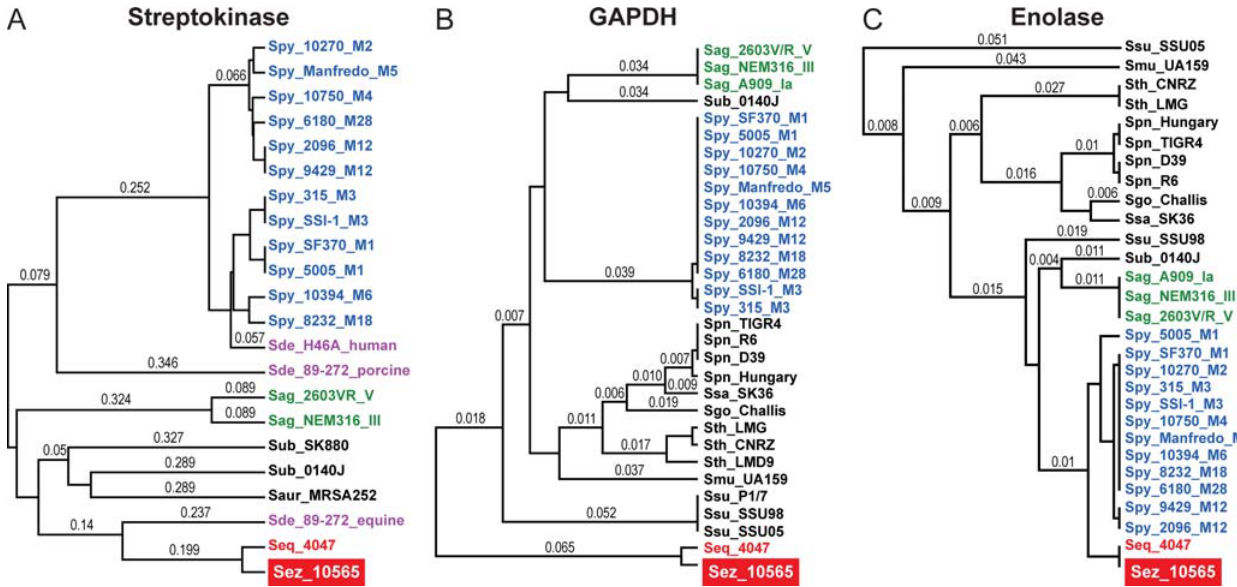
Figure 7. Genetic relationships of virulence factors implicated in PSGN pathogenesis. ( A ) Streptokinase, ( B ) GAPDH, and ( C ) Enolase. Inferred products for each of the virulence factors implicated in PSGN pathogenesis were aligned and relationships were inferred using the UPGMA method. GCS S. equi subsp. equi and zooepidemicus strains are shown in red, GAS S. pyogenes in blue, GBS S. agalactiae in green, GCS/GGS S. dysgalactiae subsp. equisimilis in purple, and other streptococcal species in black. These virulence factors are not more closely related between S. zooepidemicus and S. pyogenes than among the other streptococcal species.